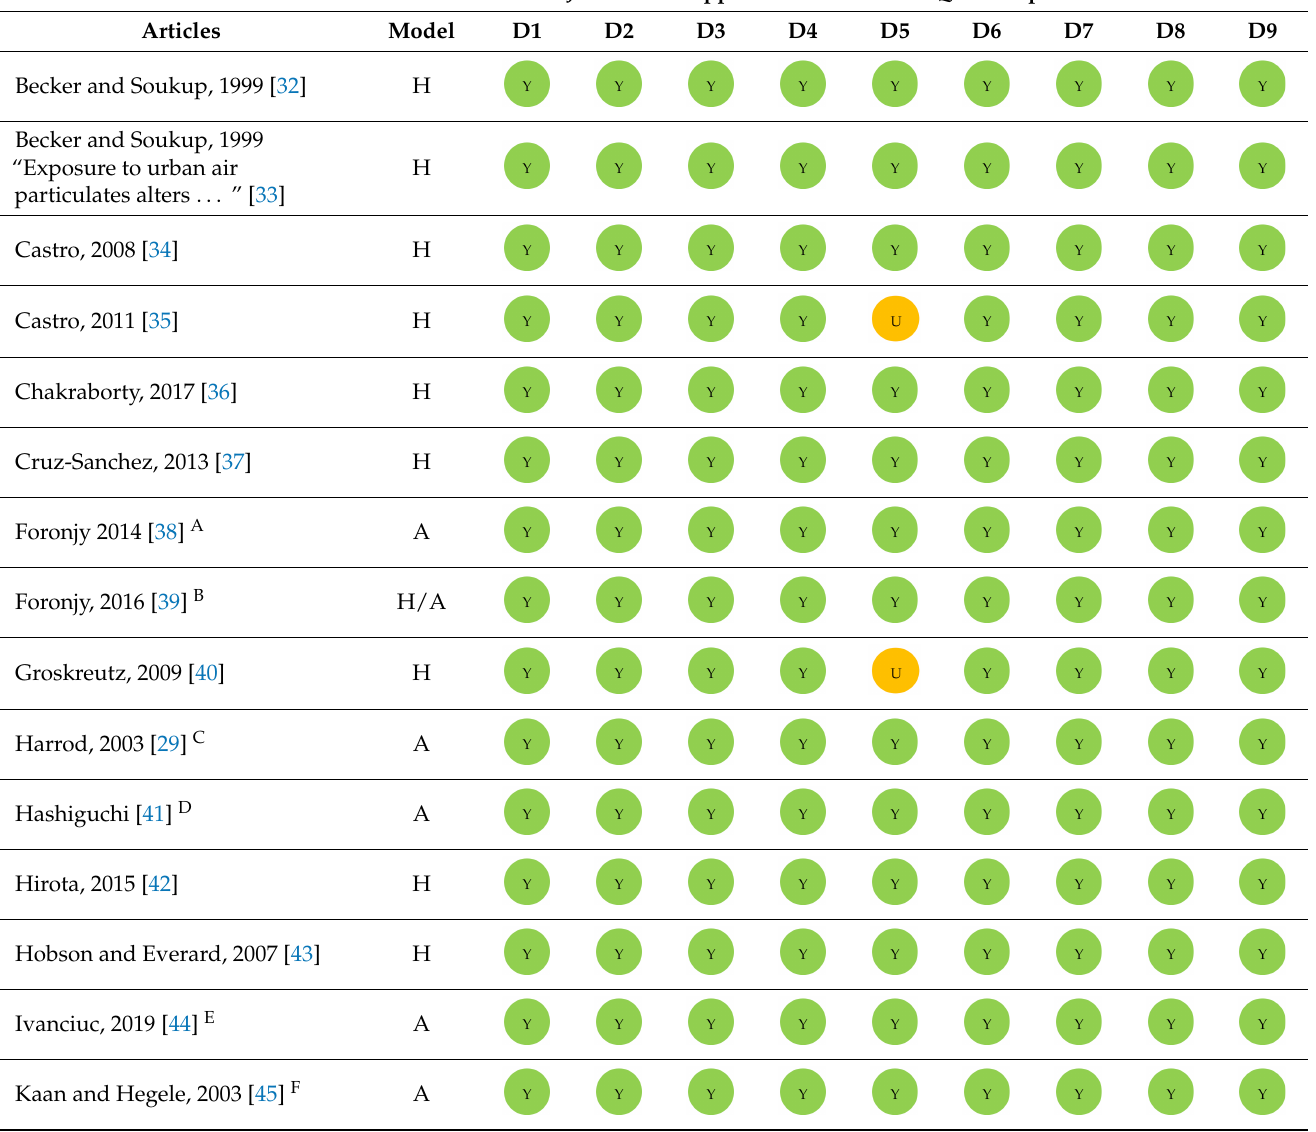
Table 3. A risk of bias assessment (critical appraisal) with the use of Joanna Briggs Institute Check- list for Quasi-Experimental Studies (non-randomized experimental studies); for detailed domains, (numbered D1–D9) please refer to Supplementary Table S3. Abbreviations: Y: yes, N: no, U: unclear. Model used in the study—H: human, A: animal, H/A: mixed human and animal. Reference